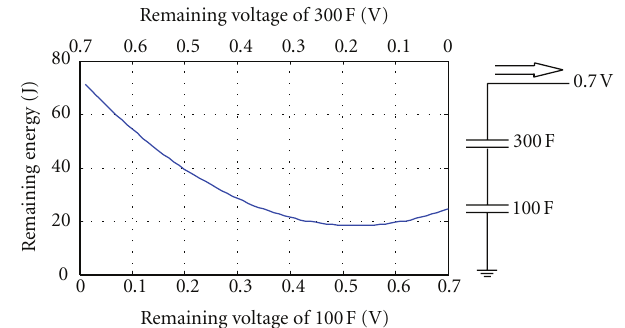
Figure 7: Di ff erent voltage